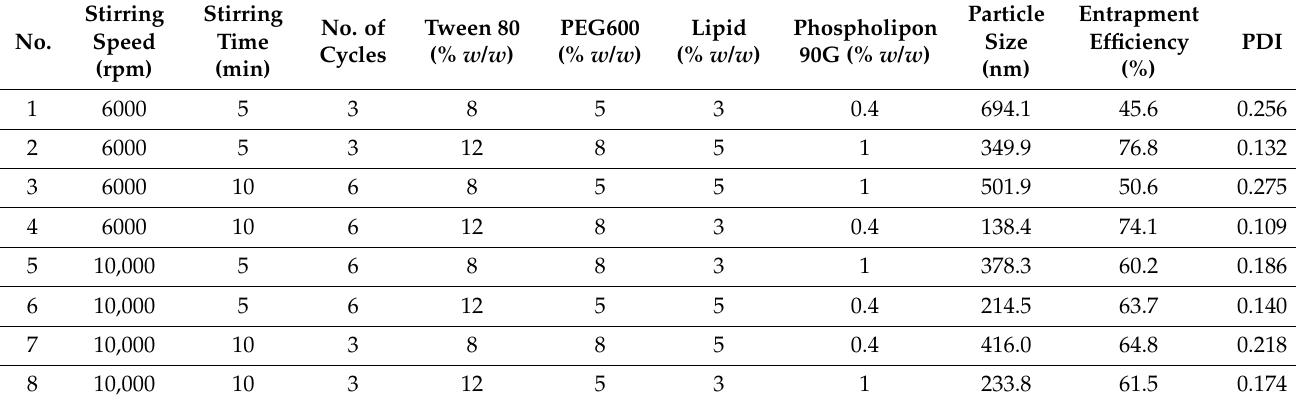
Table 1. Designed formulations for the evaluation of CSLNs using the Taguchi